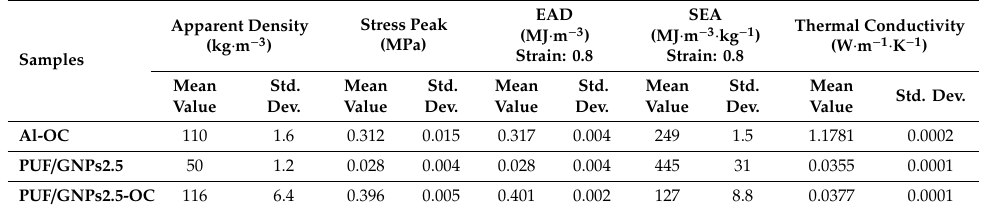
Table 4. Apparent density, stress peak, energy absorption, specific energy absorption, and thermal conductivity (n =